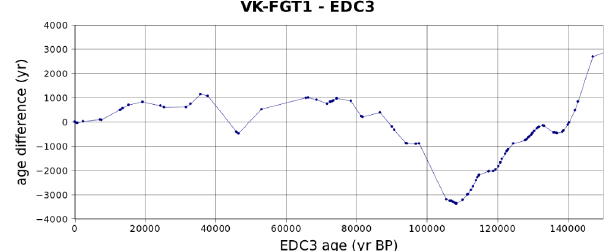
Fig. 8. Comparison of the VK-FGT1 and EDC3 time scales at the volcanic synchronisation tie